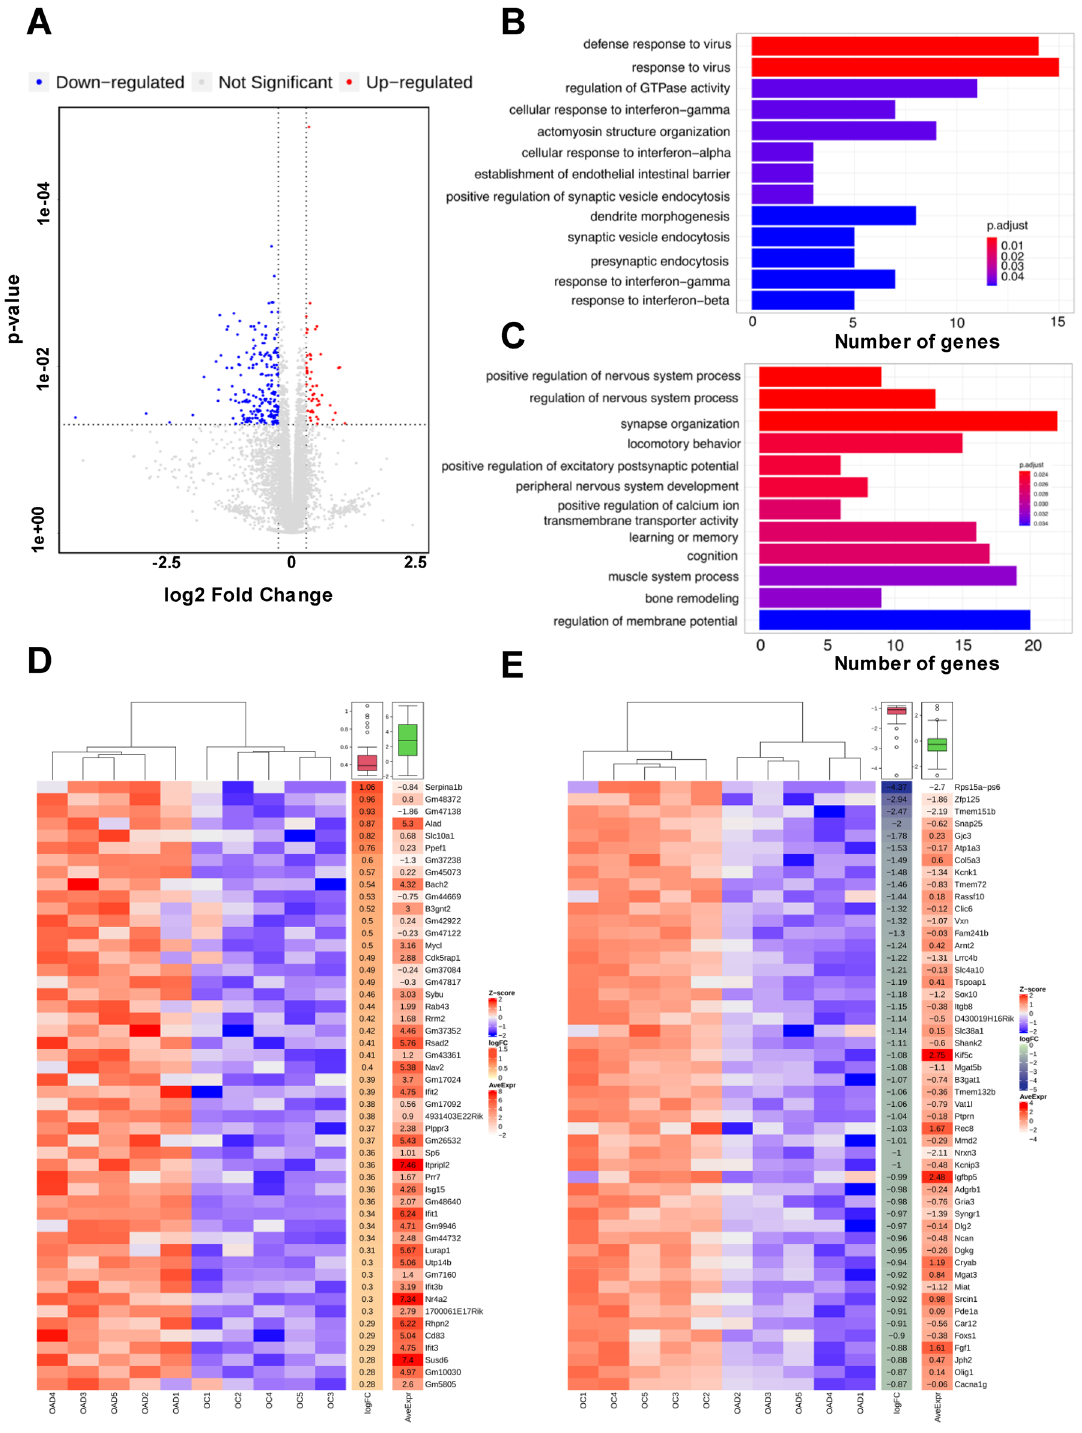
Figure 3. Transcriptomic analysis of brain endothelium in 1 year old APP/PS1 female mice and age-matched control female mice. ( A ) Volcano plot of DE mRNA transcripts analyzed in 1 year old APP/PS1 female mice against age-matched control female mice. The horizontal axis is the log2 fold change of transcripts. The vertical axis is statistically significant. Each dot represents an individual transcript (blue: down-regulated transcript; red: upregulated transcript; grey: no significant difference). The vast majority of differentially expressed genes are downregulated in the APP/PS1 female mice. ( B ) Gene ontology (GO) enrichment analysis of upregulated DE genes in the APP/PS1 female group versus control female group. ( C ) GO enrichment analysis of downregulated DE genes in the APP/PS1 female group versus control female group. Genes were considered upregulated in disease conditions if they were increased log2(fold change) > 1.00 with p < 0.05 and considered downregulated if log2(fold change) < − 1.00 with p < 0.05. The horizontal axis represents the number of genes for each GO term. ( D , E ) Heat map of the top 50 differentially expressed (upregulated and downregulated) endothelial genes between APP/PS1 females and control females. DEG (p < 0.05 and |log2 fold change| > 1), and their average expression values are presented in the side columns Each row represents one gene. Orange denotes higher gene expression and blue represents lower expression. Intensity of color is determined by a Z -score normalized by